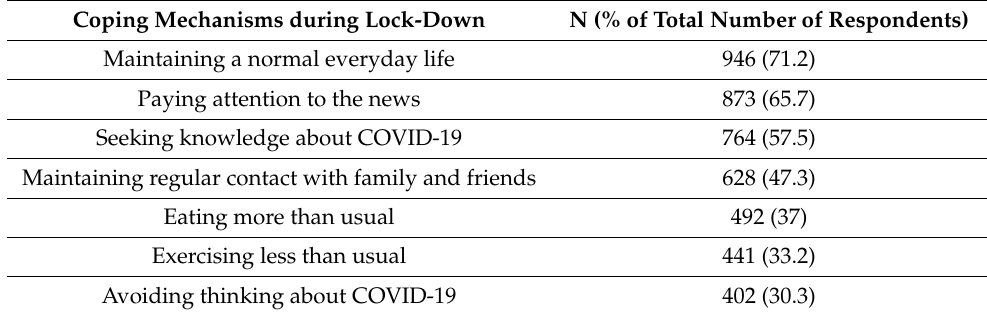
Table 3. Coping mechanisms during lock-down among respondents in the anonymously completed self-report survey in the Faroe Islands conducted from 13 April until 4 May 2020, n =